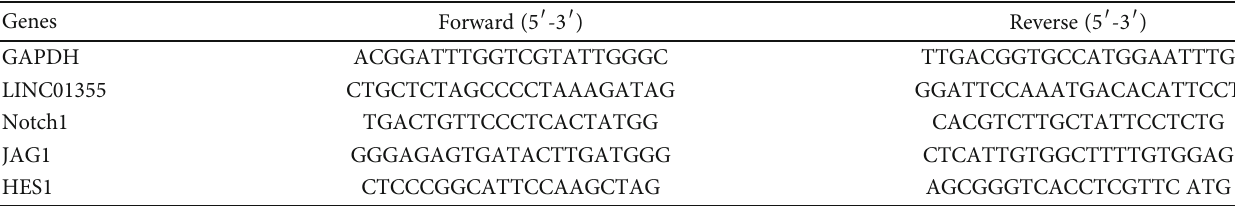
Table 1: Primers for real-time